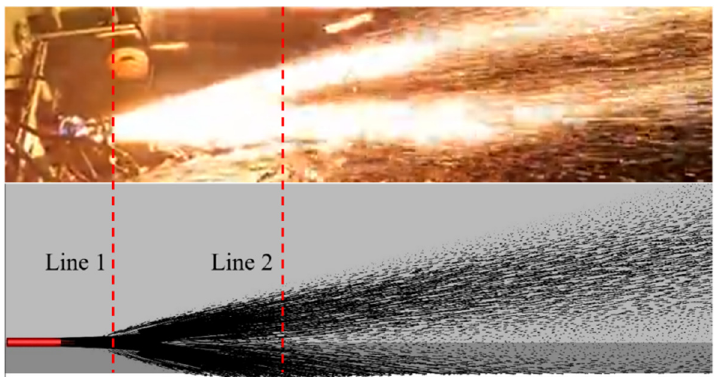
Figure 4. Working condition of corner cleaning of casting slab in factory and velocity vector on the upper and right surfaces of casting slab.